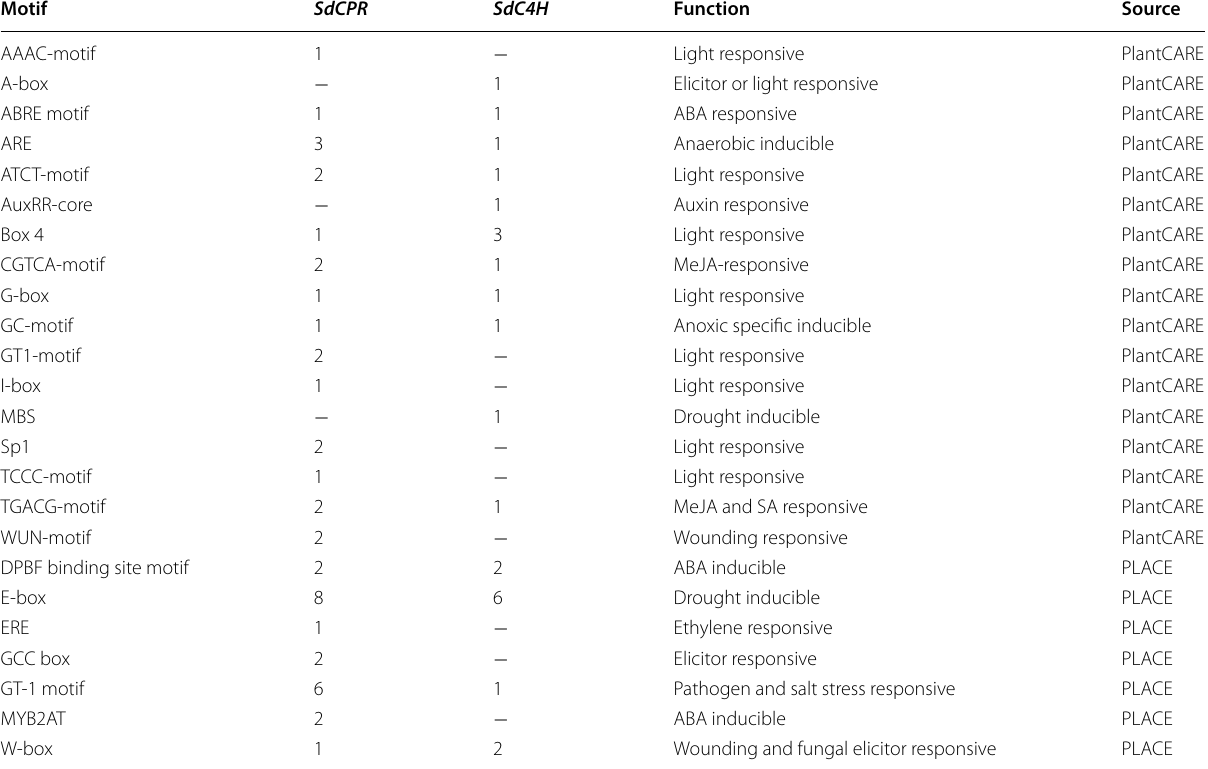
Table 4 Putative cis -acting elements in the SdCPR and the SdC4H promotors related in phytohormone and stress